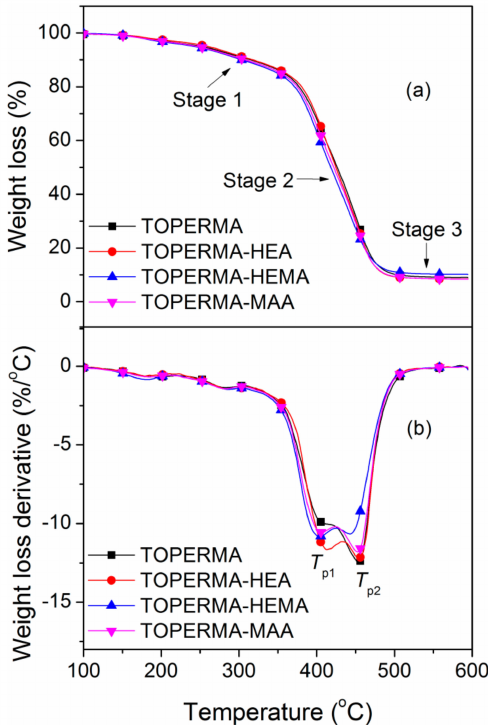
Figure 4. ( a ) TGA curves and ( b ) their derivatives of the cured TO-based